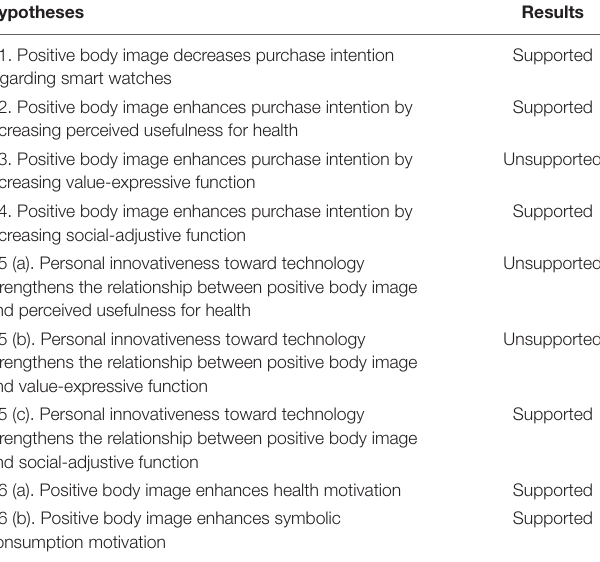
TABLE 6 | Summary of